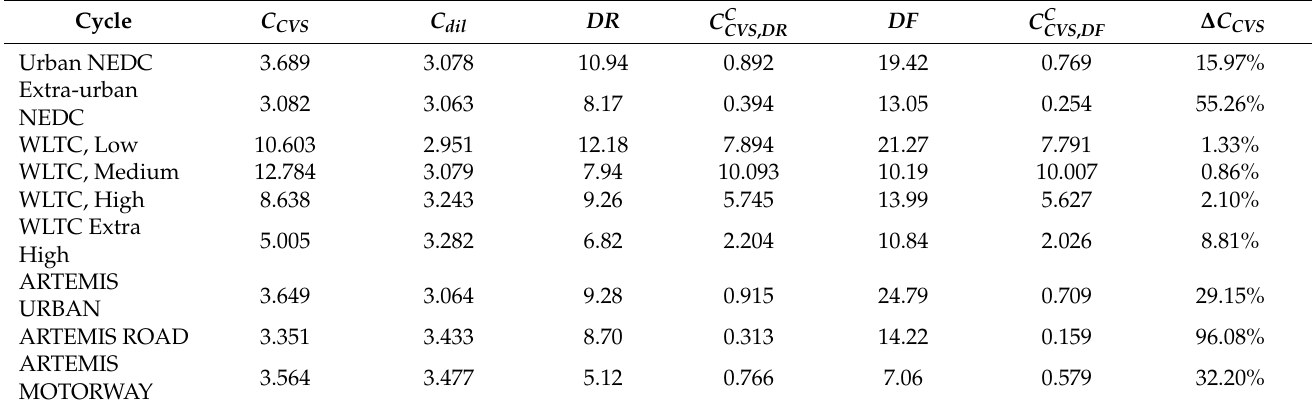
The C CVS,corr calculated based on Equations (5) and (21) for Euro 5 vehicle with CI engine, THC concentration [ppm].